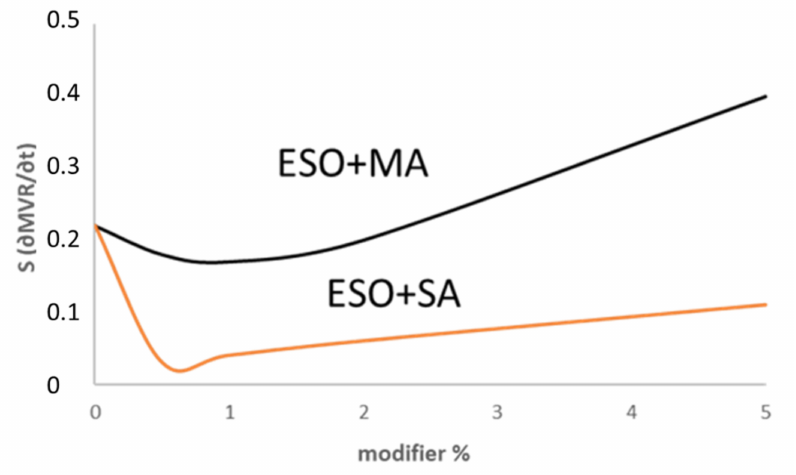
Figure 6. Slope of MVR (time) curves as a function of modifier wt % for bran composites treated with ESO + MA or ESO +